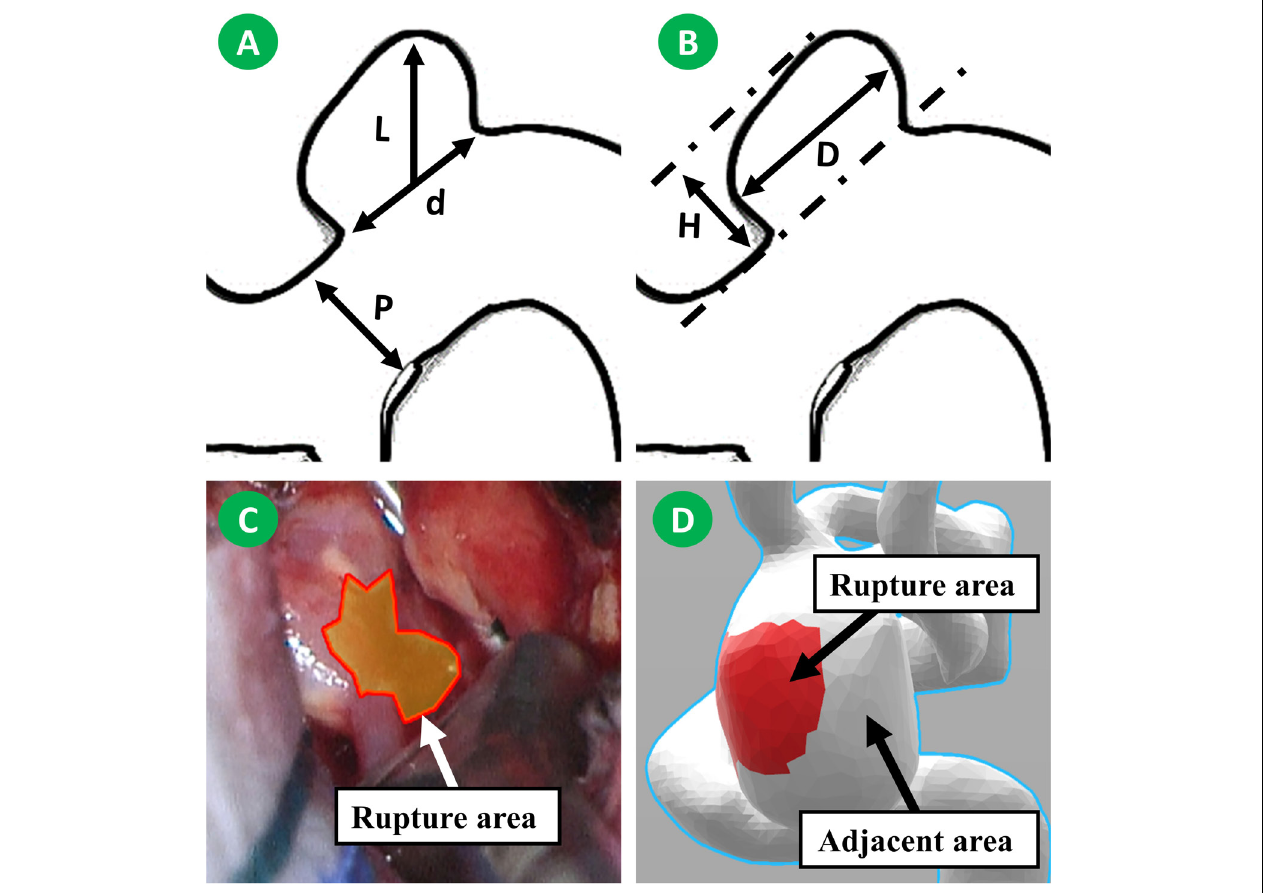
FIGURE 1 | Morphological parameters were measured from CTA image. H is the maximum perpendicular distance of the dome from the neck plane. L is the maximum distance of the dome from the neck plane. d is the average diameter of the neck. p is the average diameter of the parent artery. D is the maximum diameter of the body (A,B) . We have roughly matched the rupture area on the vascular model. Subsequently, the hemodynamic changes in rupture area and adjacent area were monitored (C,D)